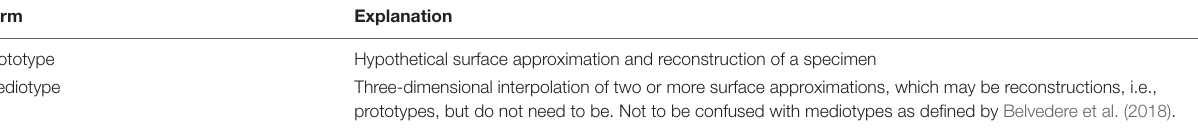
TABLE 1 | Definition of technical terms.